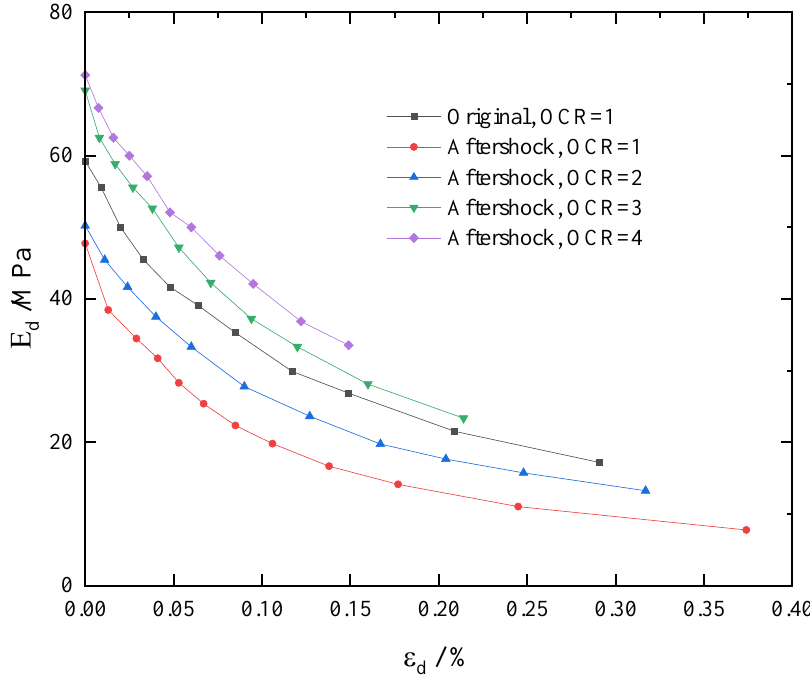
Figure 8. Dynamic elastic modulus: dynamic strain curves of the saturated loess under different reconsolidation conditions.